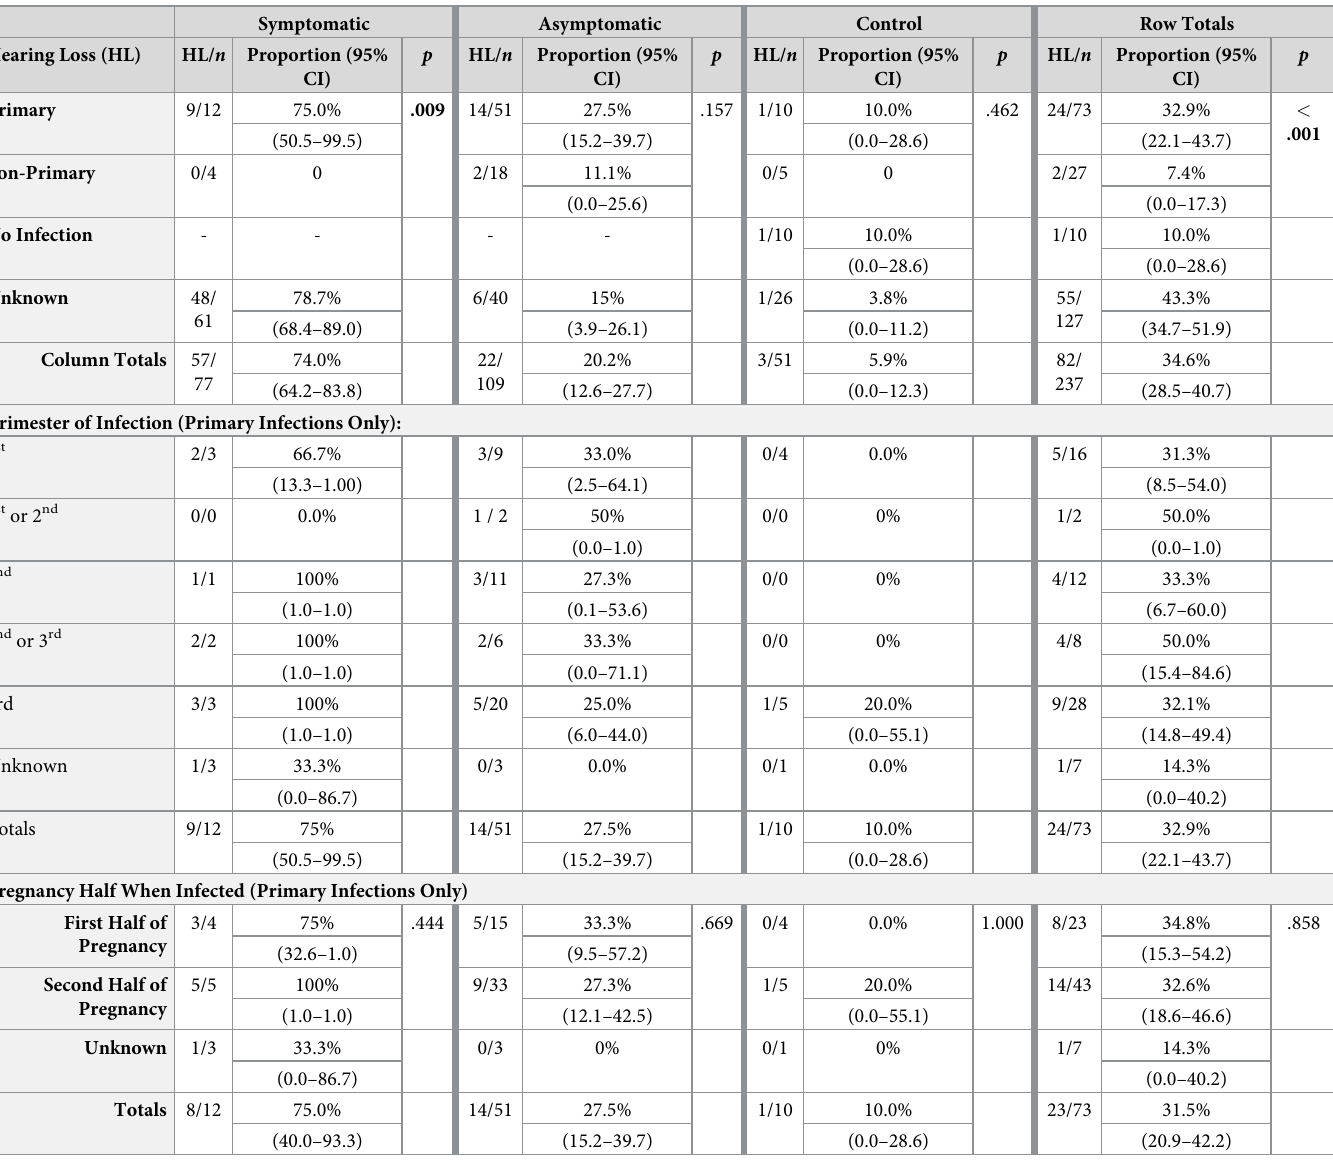
Table 3. Proportions of newborns with congenital CMV infection with and without hearing loss by age 18 years of age, and type of maternal CMV